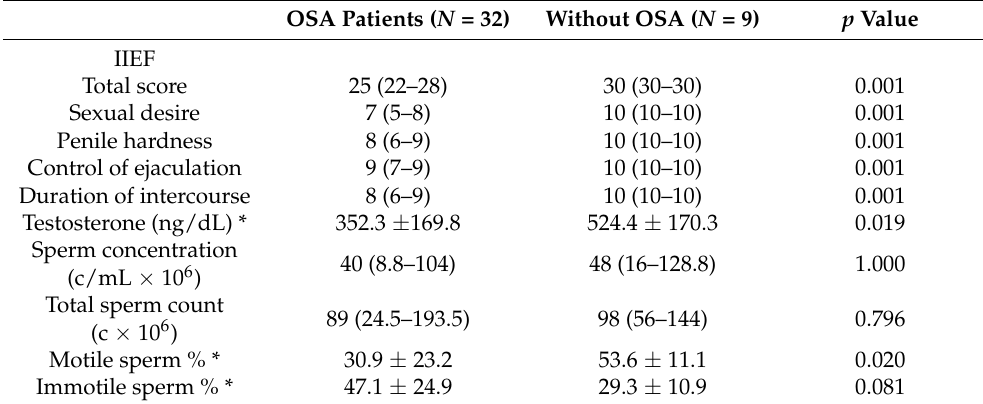
Table 2. Erectile and sexual function of the two groups (OSA patients vs. control group without OSA). Median, interquartile range, unless otherwise